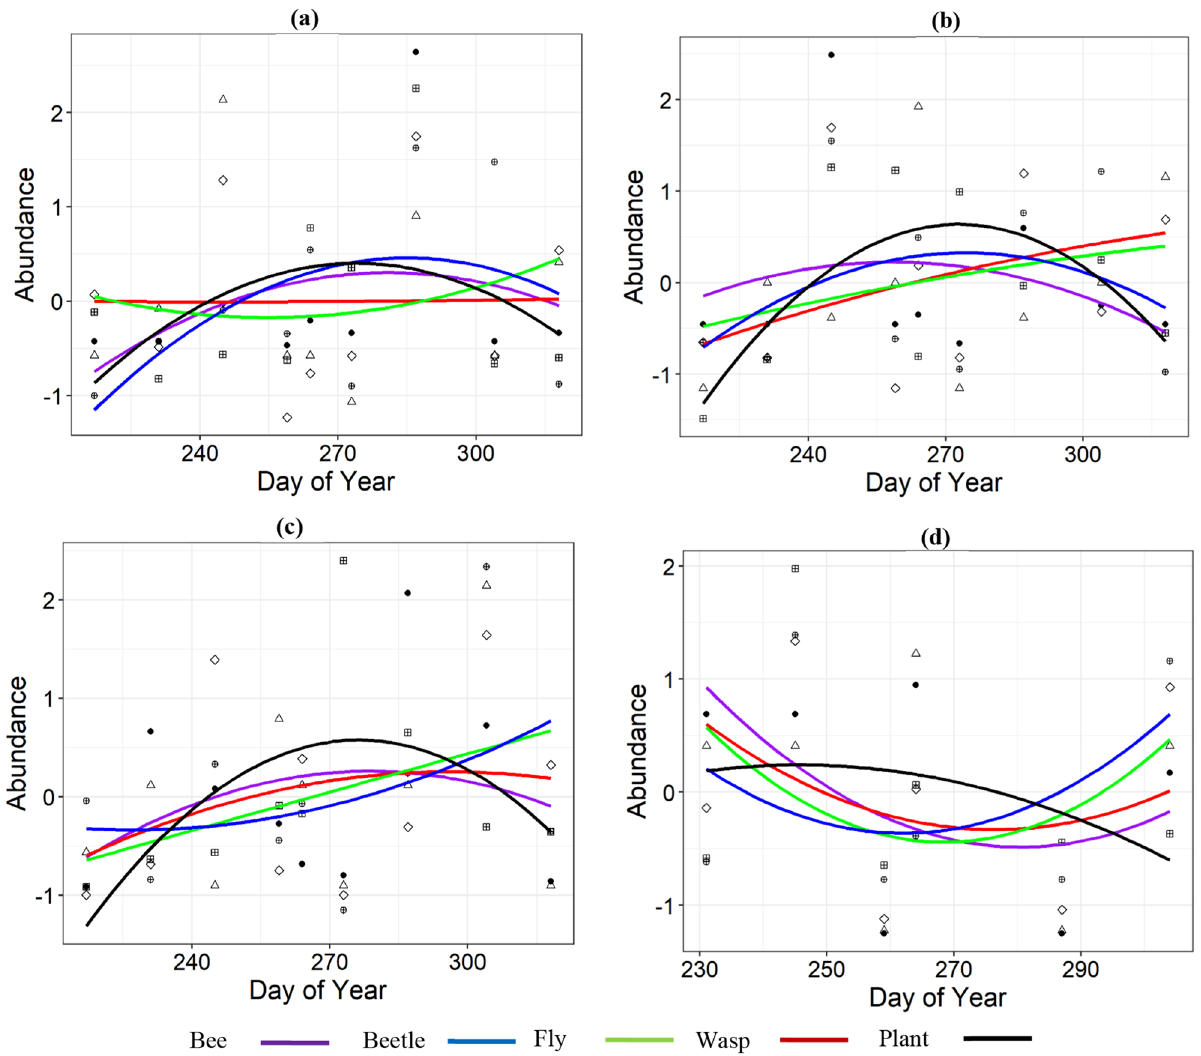
Figure 5. Abundance of insect taxa and flowering plants across sampling days in the ( a ) base zone, ( b ) middle zone, ( c ) high zone, and ( d ) summit zone. Lines represent the best models for and the dots represents abundance recorded at each sampling